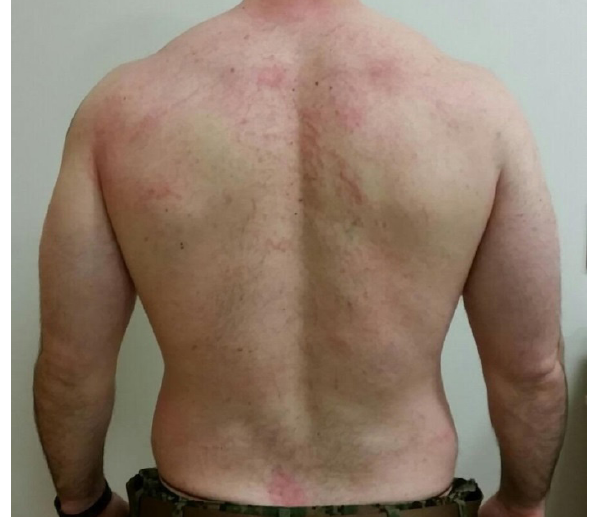
Image 1b. Sequential photo on day 2 after initiating steroid burst.